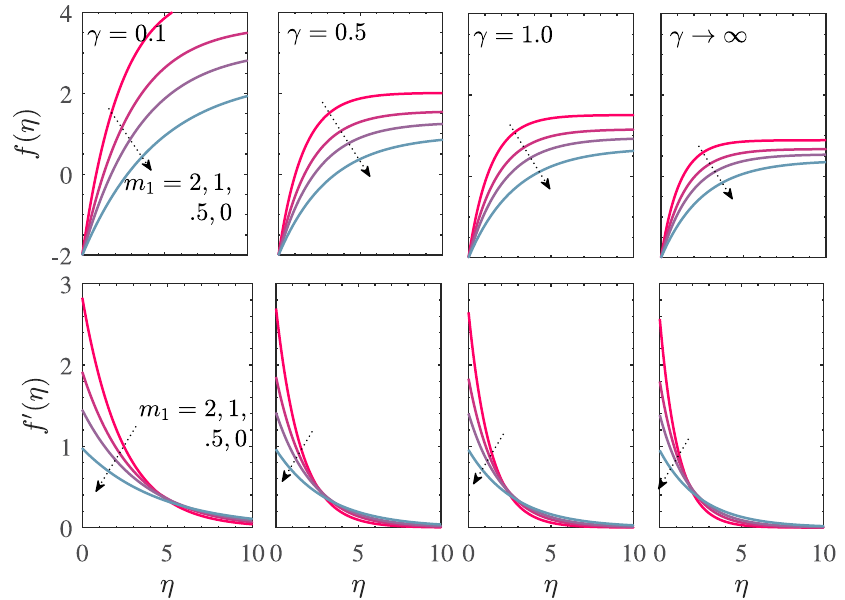
Fig 10. α vs V (a) M = 0 (b) M = 5. The fixed parametric values are γ 1 = 0.1 = − γ 2 , d = 1+ m 1 for the stretching sheet c case with mass injection. Here, all solutions are found to be unique.